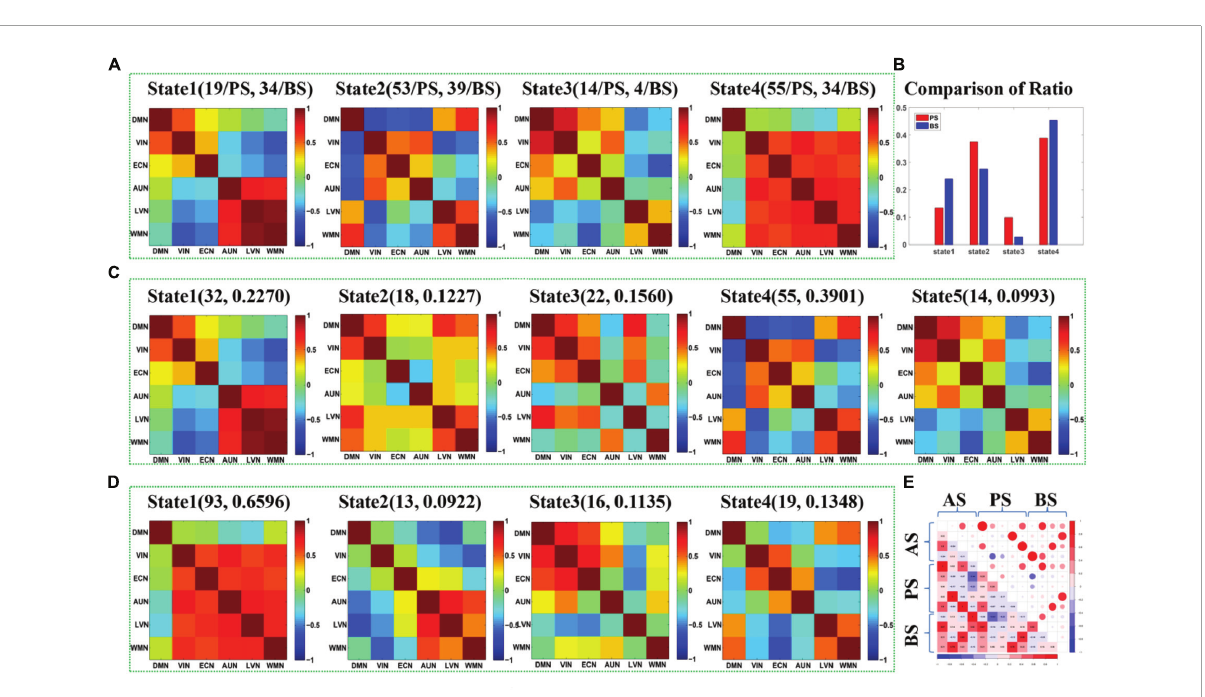
FIGURE3 (A) The maps of four DFC states (State1-State4) extracted from the DFCs of presailors and backsailors at the group level, and the digits in parentheses on the top of each subfigure represent the number of DFCs contained in this state for presailors (PS) and backsailors (BS), respectively; (B) The histogram of proportion of the DFCs number corresponding to presailors and backsailors contained in each state of (A), respectively; (C) The maps of five states (State1-State5) extracted from the DFCs of presailors at the group level, and the digits in parentheses on the top of each subfigure represent the number and ratio of DFCs contained in this state; (D) The maps of four DFC states (State1-State4) extracted from the DFCs of backsailors at the group level, and the digits in parentheses on the top of each subfigure represents the number and ratio of DFCs contained in this state; (E) the correlation diagram between the three groups of DFC states in (A,C,D)